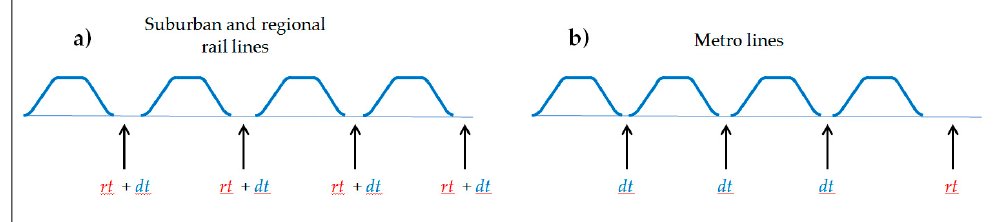
Figure 4. Reserve times for suburban and regional lines ( a ) and metro lines ( b ).